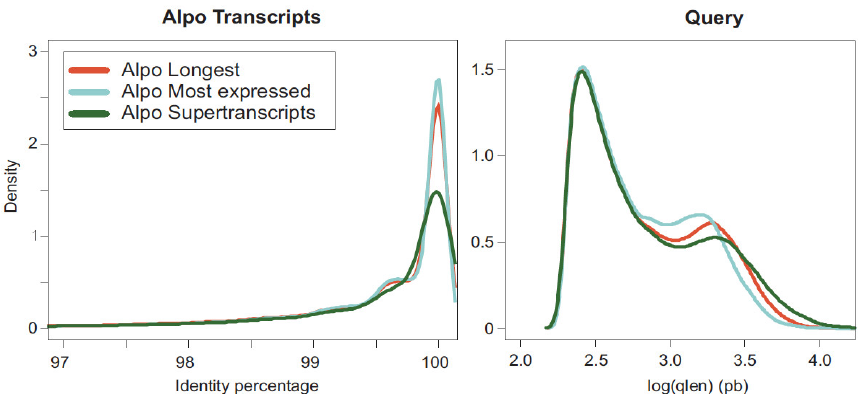
Figure 1. Alignments to the Lens culinaris reference. Alignments of three types of transcript repre- sentatives of the Alpo ( Lens culinaris ) transcriptome to the CDC Redberry reference genome. These representatives are: the longest transcript isoform of each gene; the isoform that is most expressed; and the SuperTranscripts. The density functions of the identity percentages of the alignments ( left ) as well as the aligned query lengths ( qlen ) ( right ).